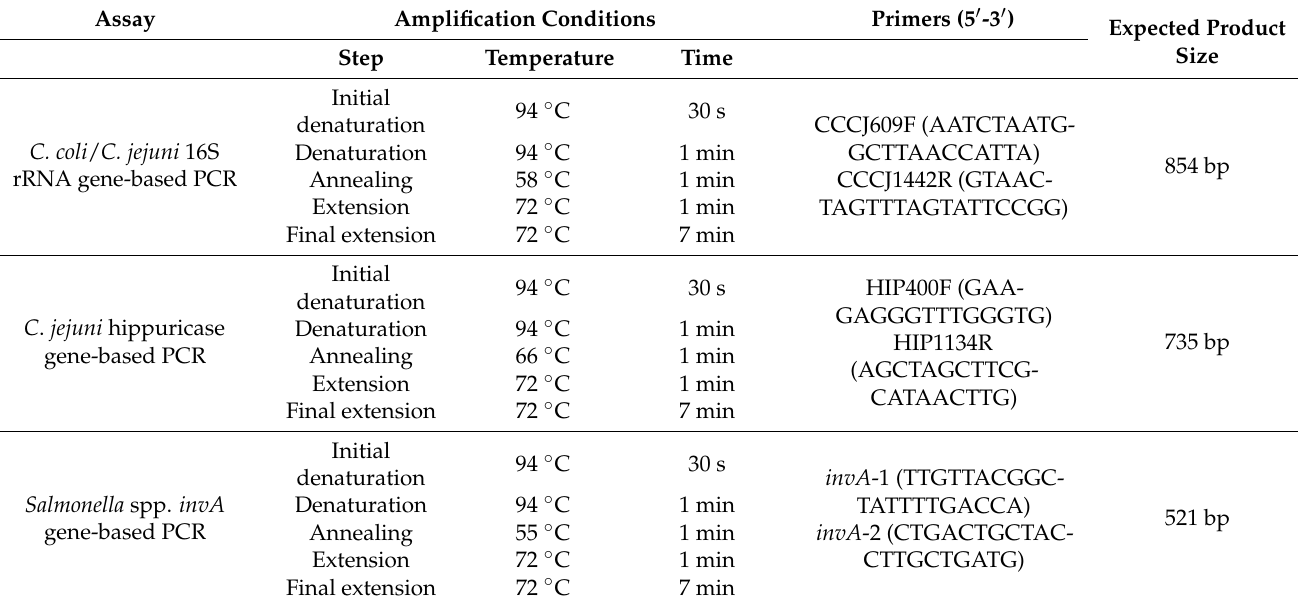
Table 1. Amplification conditions and the primers used for the co-amplification of Campylobacter jejuni and C. coli , and the amplification of C. jejuni and Salmonella spp. in faecal samples collected from